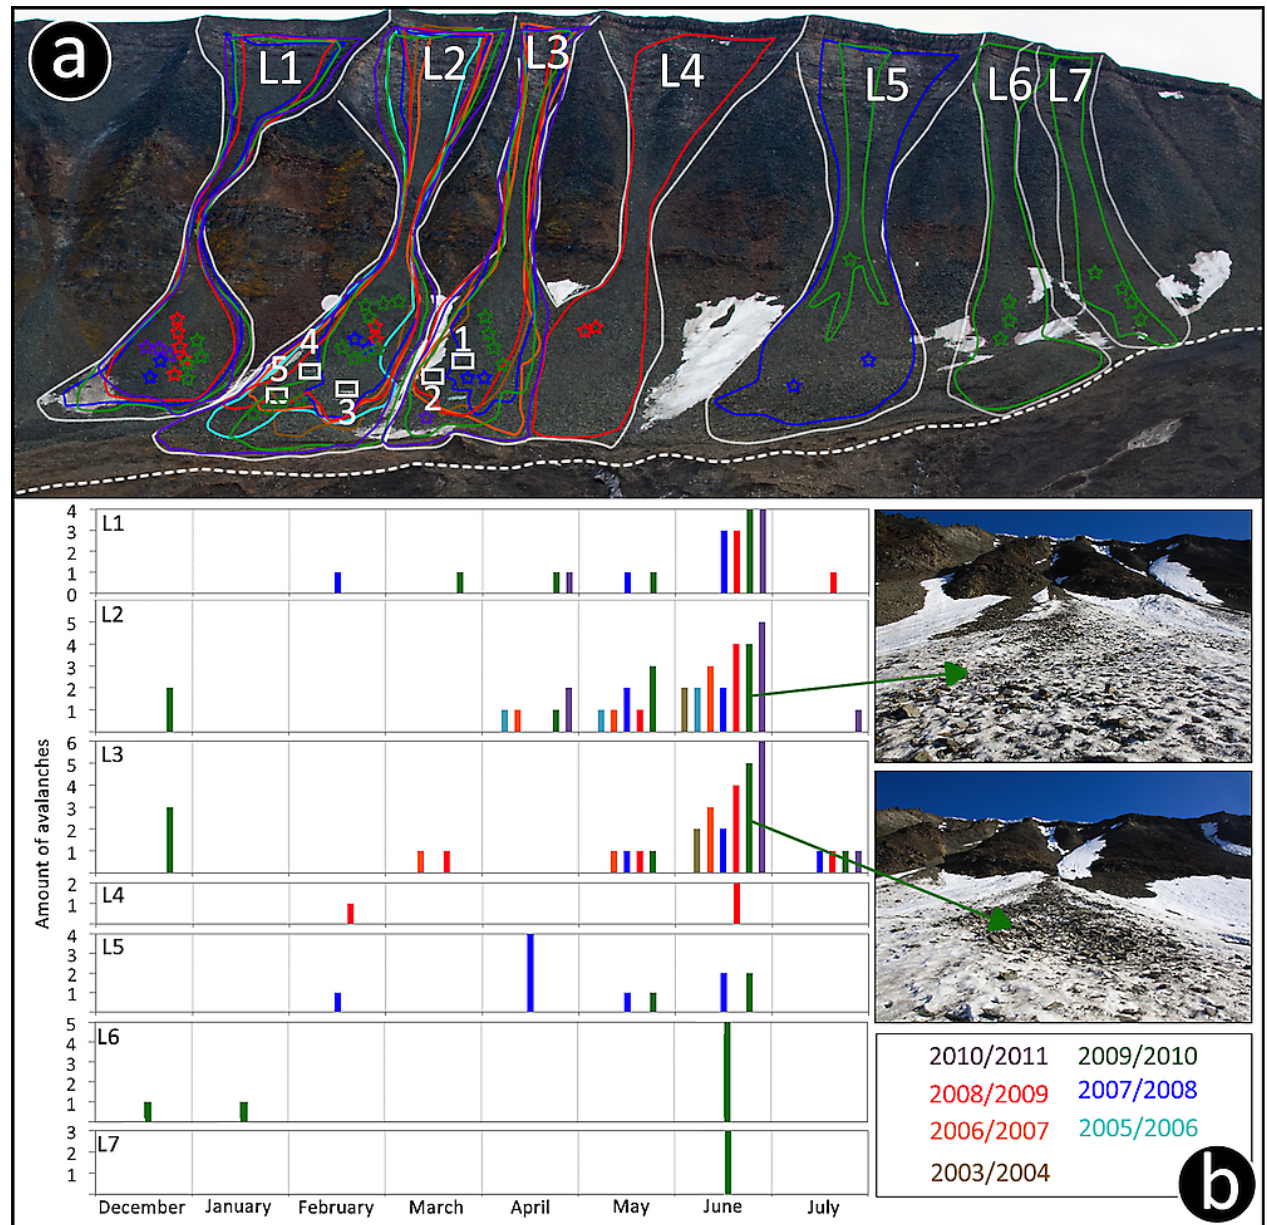
Fig. 6. (a) Outlines of the maximum annual extent of avalanche snow deposition in the Nybyen slope system. The stars indicate the location of directly measured avalanche deposited rock debris from sediment or snow traps. (b) Amount of annual avalanches that released in each catchment (Table 1). The two pictures exemplify two avalanche snow deposits in which snow inventories were carried out. The avalanches released in catchments L2 and L3 in 2009/2010. Note the highly visible rock debris content in both